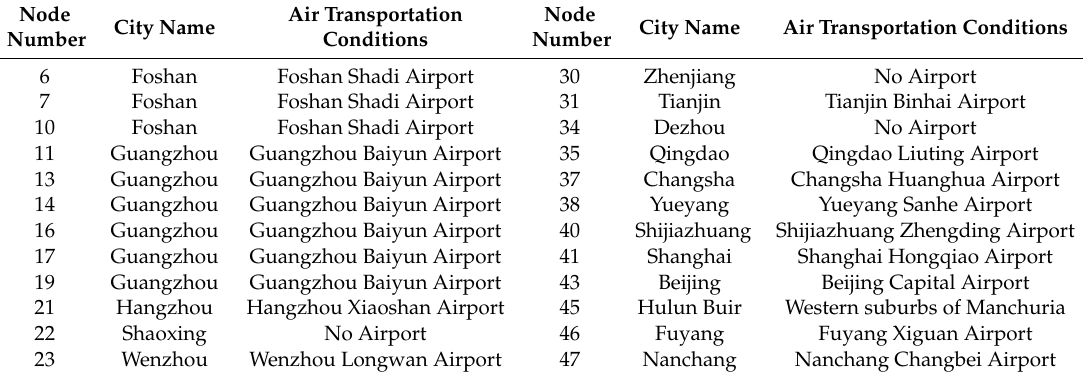
Table 2. Air transportation conditions in 47 timber markets (enumeration).